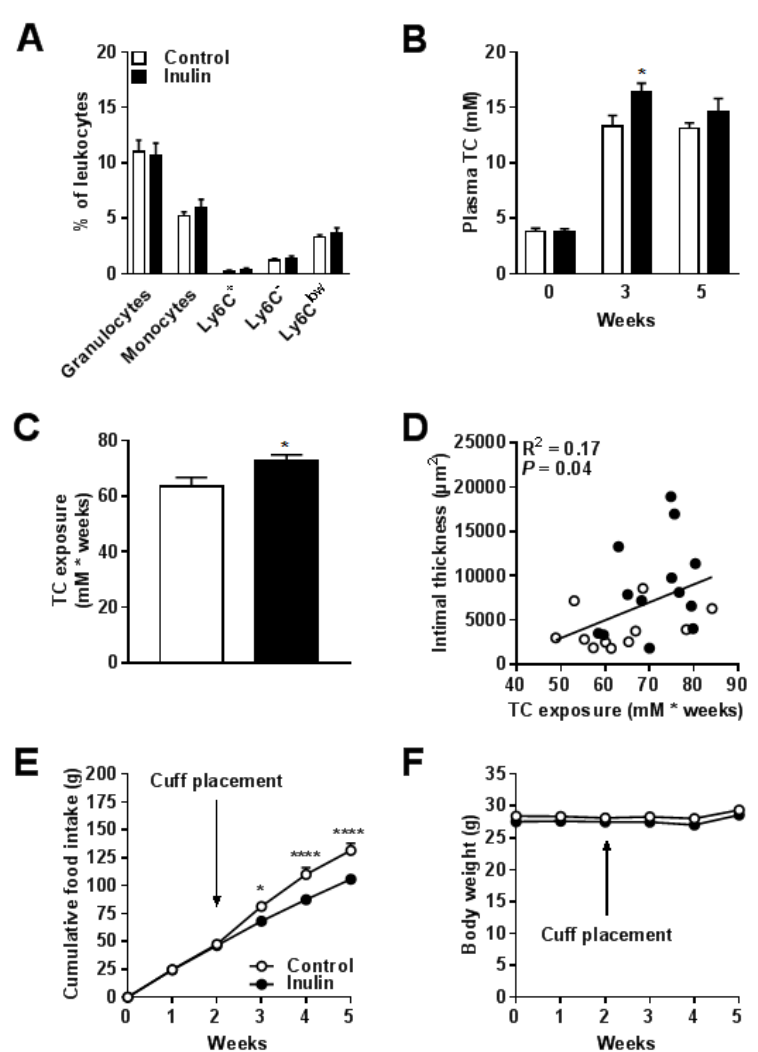
Figure 4. Inulin did not affect blood monocyte composition but increased total cholesterol exposure. ( A ) Circulating granulocytes, monocytes, and monocyte subsets Ly6C + , Ly6C low , and Ly6C - are shown as a percentage of circulating leukocytes; ( B ) Plasma TC was analyzed in week 0, 3, and 5; and ( C ) Cumulative TC exposure was calculated over the entire intervention period of 5 weeks; ( D ) TC exposure was plotted against intimal thickness; ( E ) Cumulative food intake and ( F ) Body weight over the 5-week intervention period. The arrow indicates the time point at which the cuff was placed around the femoral artery. Values are presented as means ± SEM ( n = 11–13 mice per group). * p < 0.05 vs. control.